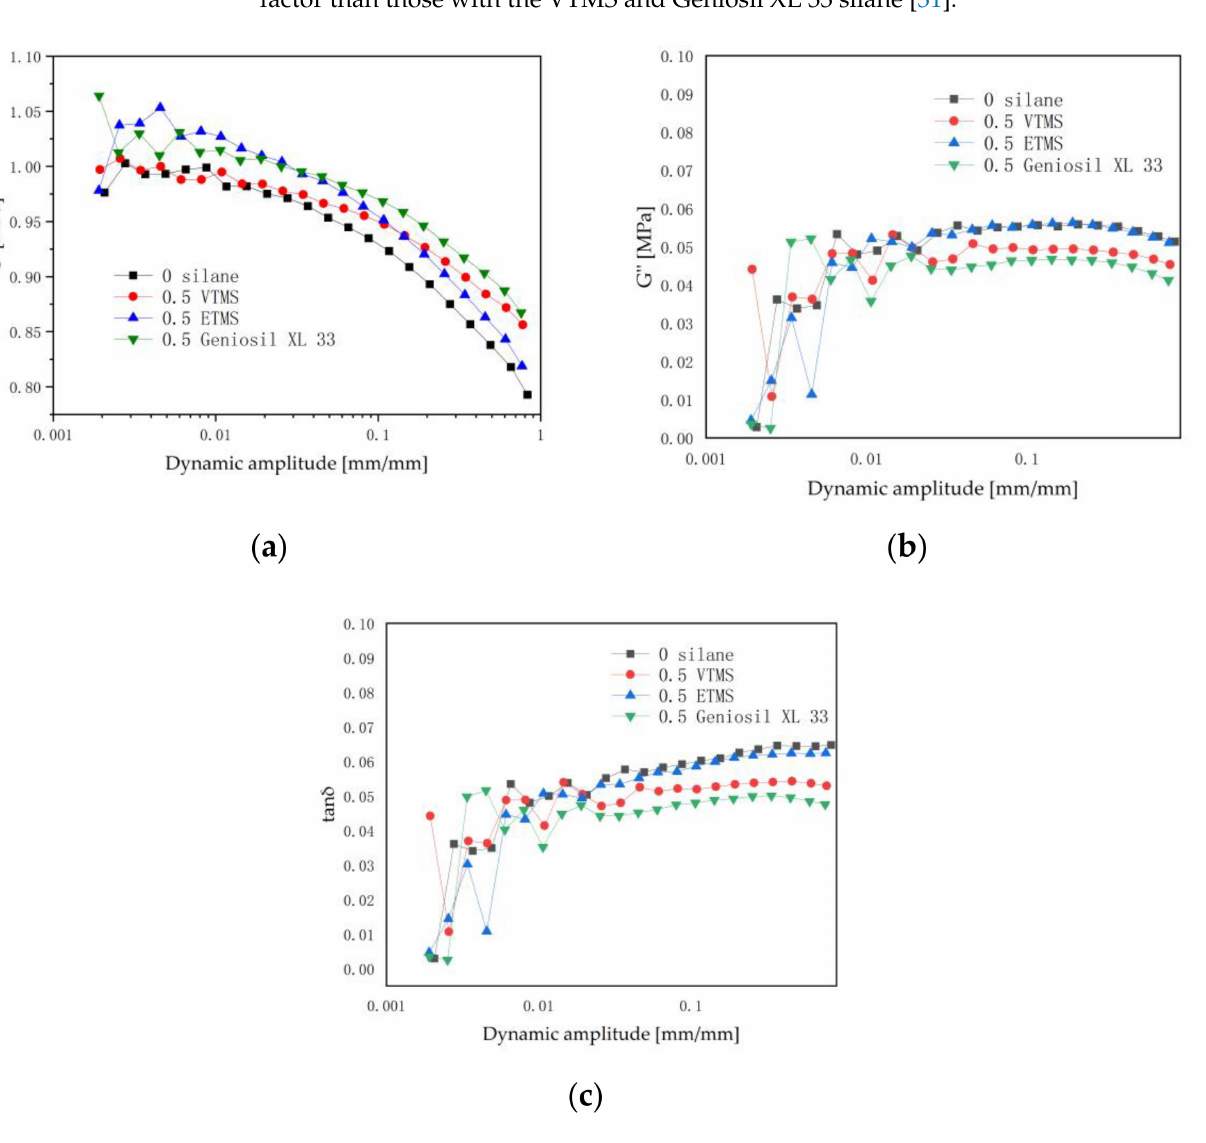
Figure 4. The curves of G’, G” and tan δ versus strain for the EPDM/CaCO 3 vulcanizates: ( a ) storage modulus (G’); ( b ) loss modulus (G”); and ( c ) loss factor (tan δ